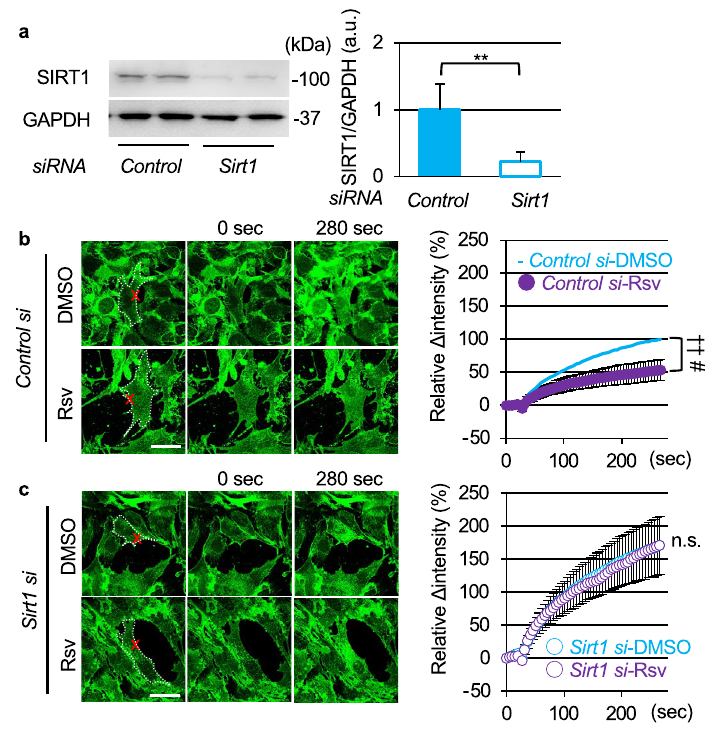
Figure 2. SIRT1 knockdown disturbs promotion of membrane resealing by resveratrol. ( a ) Western blots of C2C12 myoblasts treated with Control or Sirt1 siRNA for 48 h (n = 6). ( b and c ) Left panels show representative images, and right panels show time course of FM 1-43 dye influx before and after laser injury in C2C12 myoblasts treated with DMSO (top) or Rsv (bottom). C2C12 myoblasts were treated with Control ( b ) or Sirt1 siRNA ( c ) for 48 h before laser stimulation ( Control si -DMSO n = 30, Control si -Rsv n = 31, Sirt1 si -DMSO n = 44, Sirt1 si -Rsv n = 45). Data are represented as means ± SD ( a ) or SEM ( b , c ). A significant difference was determined by a two- tailed Student’s t -test: ** P < 0.01. For ( b ) and ( c ), † and †† indicate P < 0.05 and 0.01 at the last time point (280 s), respectively. # indicates P < 0.05 based on the AUC value. n.s. = not